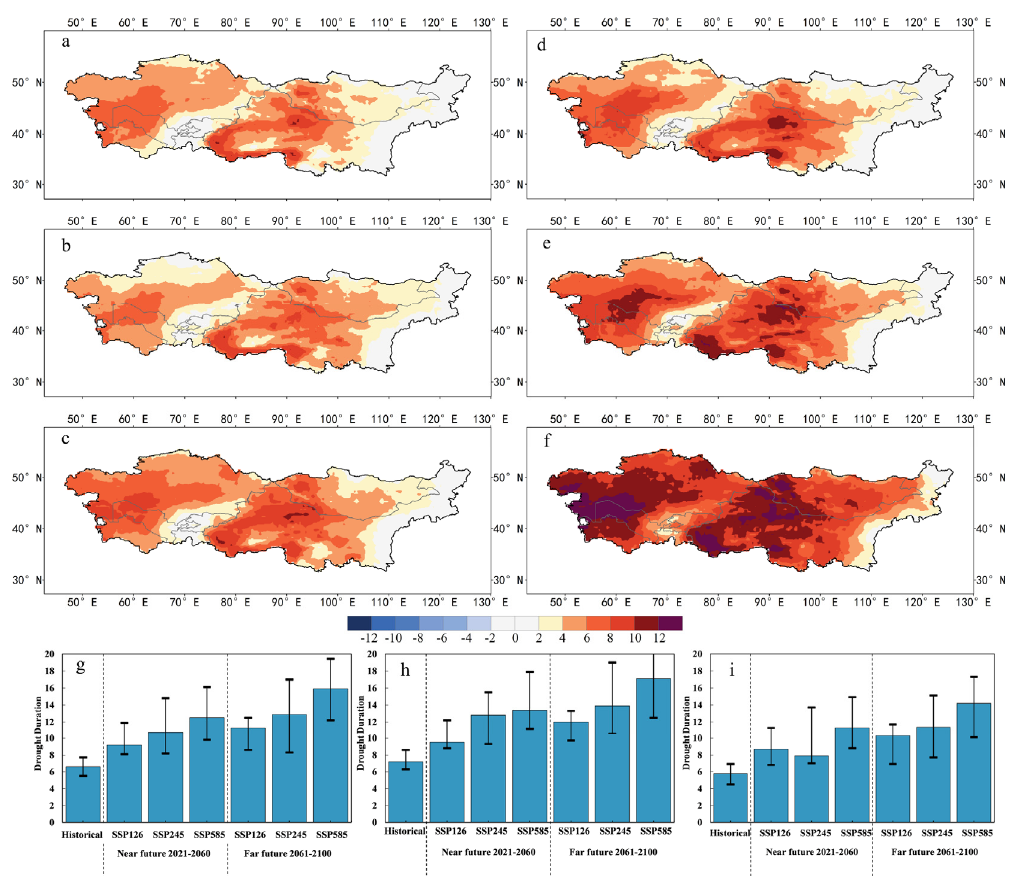
Figure 5. Spatial distribution of Asian dryland RMDD for the 2021–2060 ( a,b,c ) and 2061–2100 ( c,d,f ) cycles under SSP126 ( a,d ), SSP245 ( b,e ), and SSP585 ( c,f ) scenarios, relative to the 1961–2000 reference cycle. Changes in drought duration for 2021–2100 as identified by the SPEI drought index. Drought duration changes in Asian drylands for 2021–2060 and 2061–2100 under SSP126, SSP245, and SSP585 scenarios ( g ). Two regions ( i ) in northwest China and Mongolia ( h ) in the five Central Asian countries are delineated. The bar graphs and black vertical lines indicate the mean and range of multiple GCM projections.